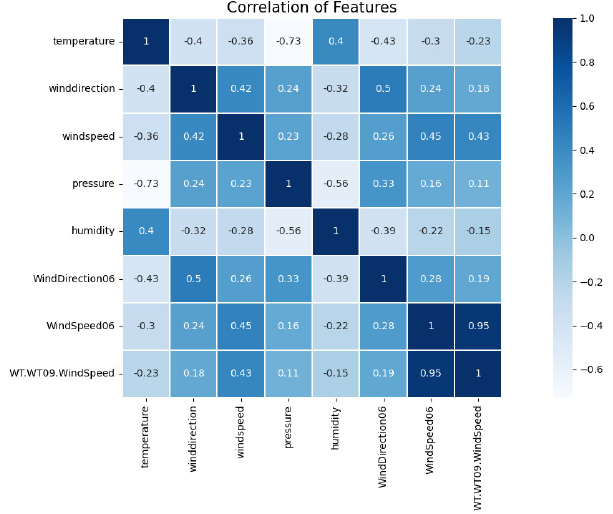
Figure 2. Heatmap for correlation analysis.